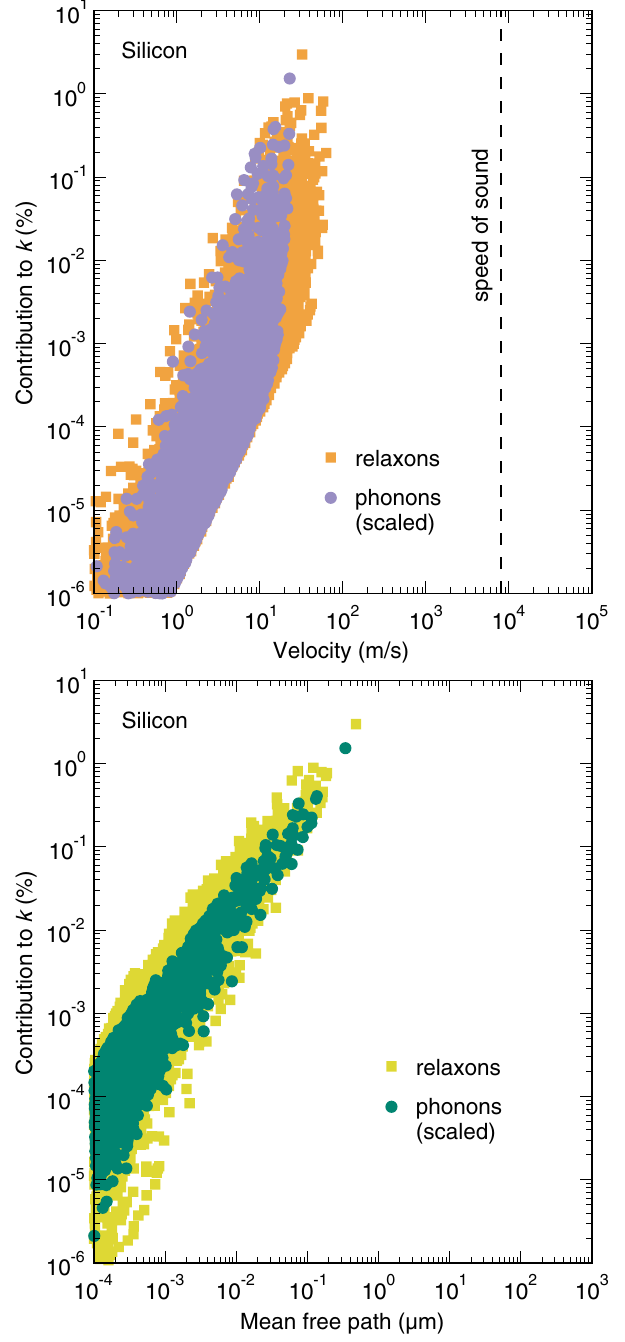
FIG. 10. Top panel: Comparison of relaxon velocities with scaled phonon velocities. Bottom panel: Same as the top panel but for mean free paths.